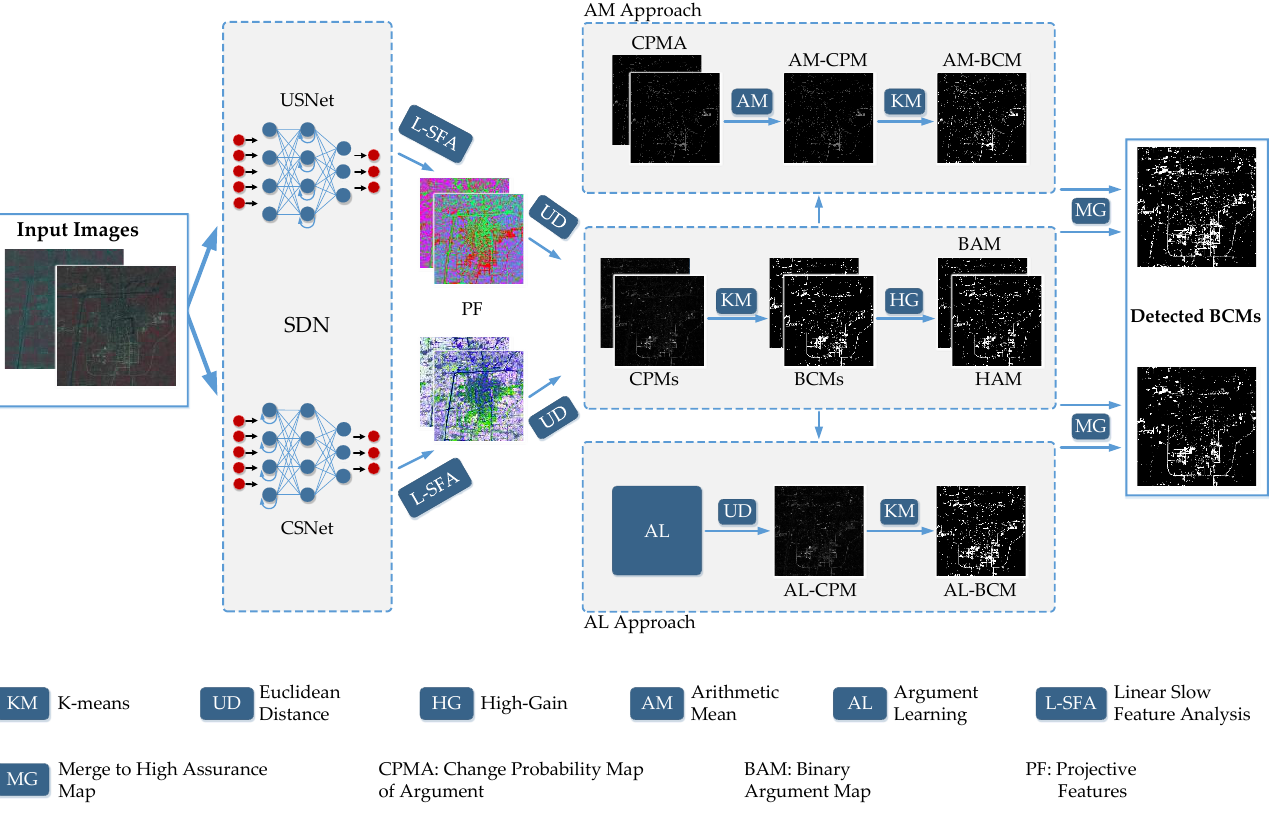
Figure 1. Flowchart of proposed CD-SDN.